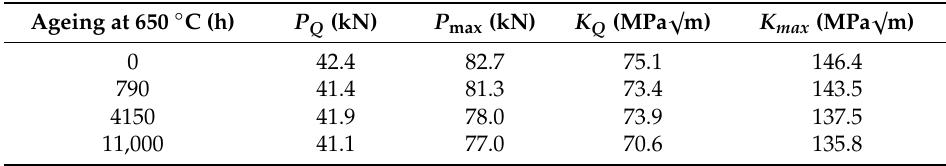
Table 3. Averaged fracture toughness test results at room temperature for the as-received and aged P91 steel.